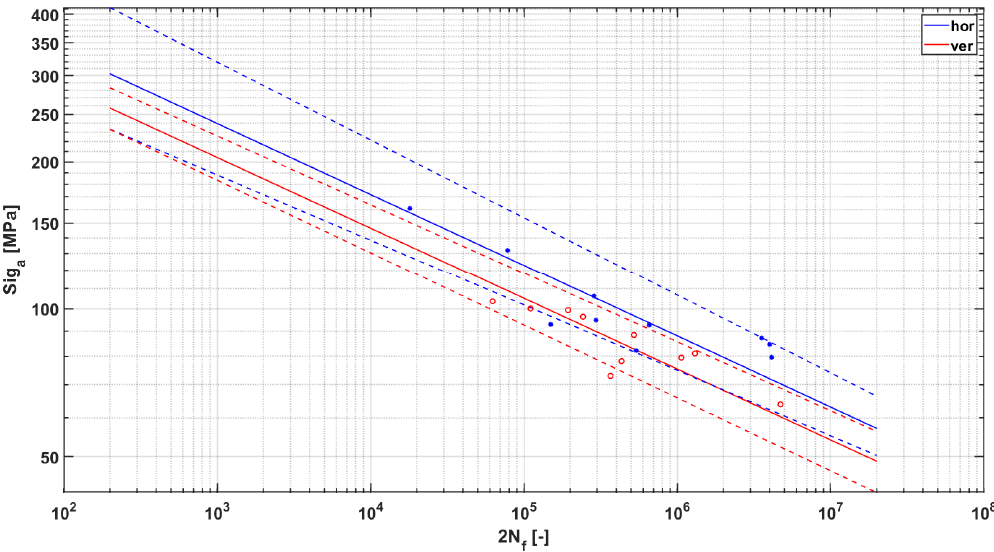
Figure 8. The Basquin curves for the AM specimens with experimental points.